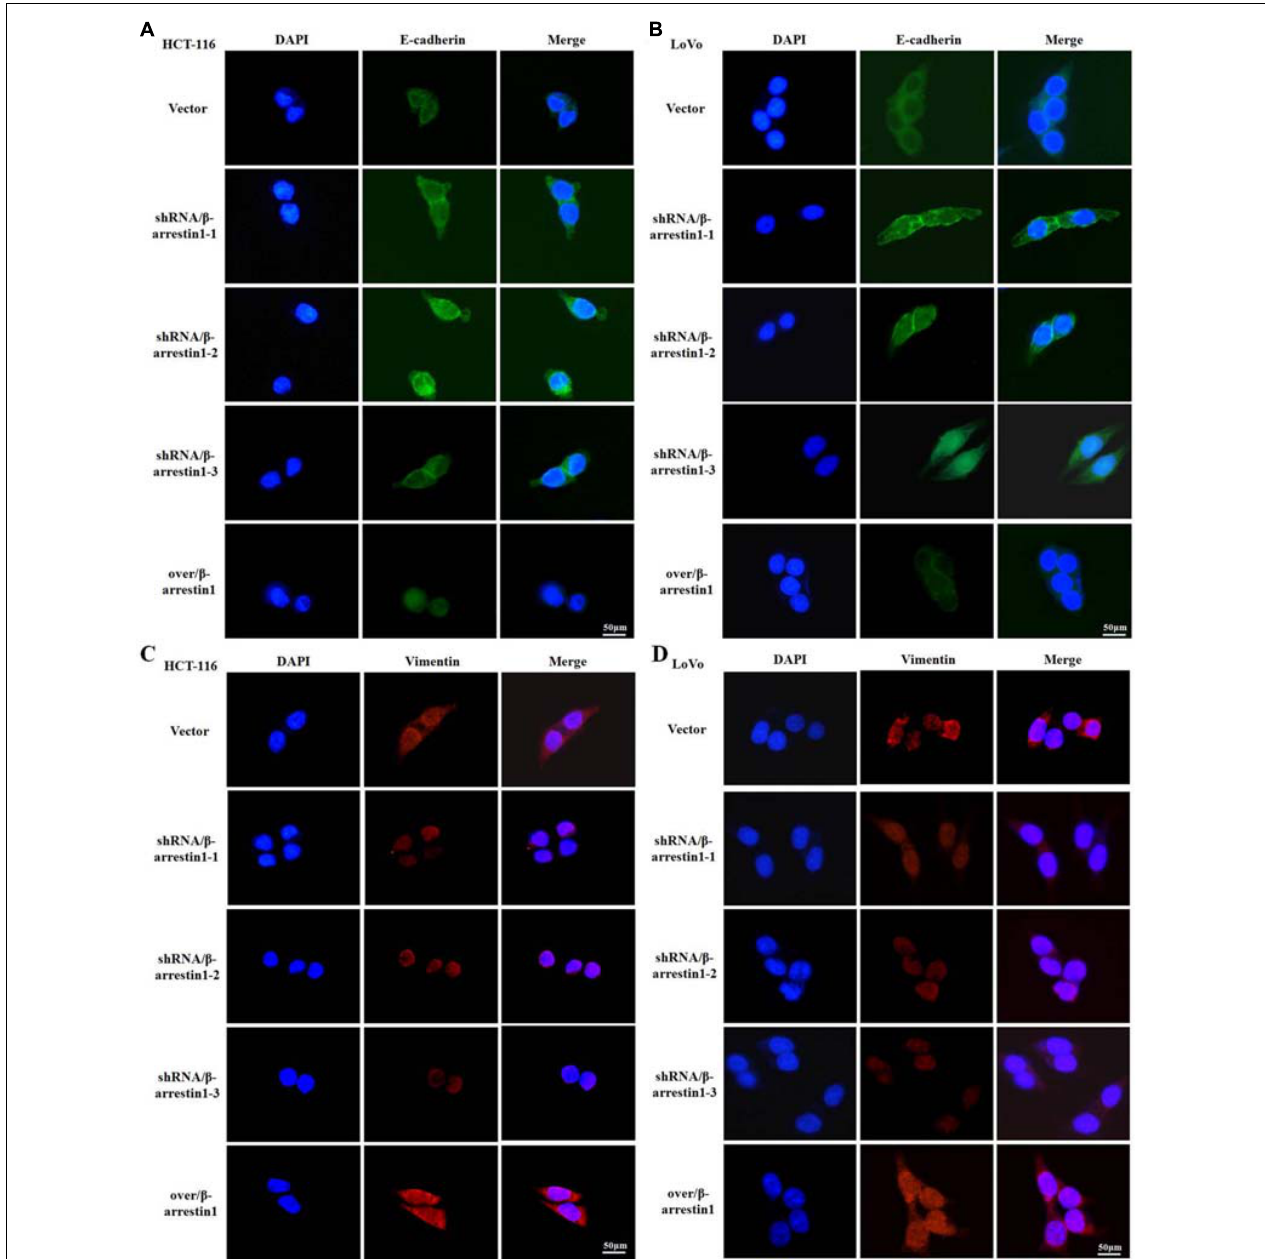
FIGURE 3 | β -arrestin1 regulates the expression and cellular location of EMT markers. (A–D) Immunofluorescence staining of E-cadherin and Vimentin (two typical EMT markers) in HCT-116 or LoVo cells transfected with shRNA/ β -arrestin1 or over/ β -arrestin1 lentivirus. EMT, epithelial-to-mesenchymal transition.